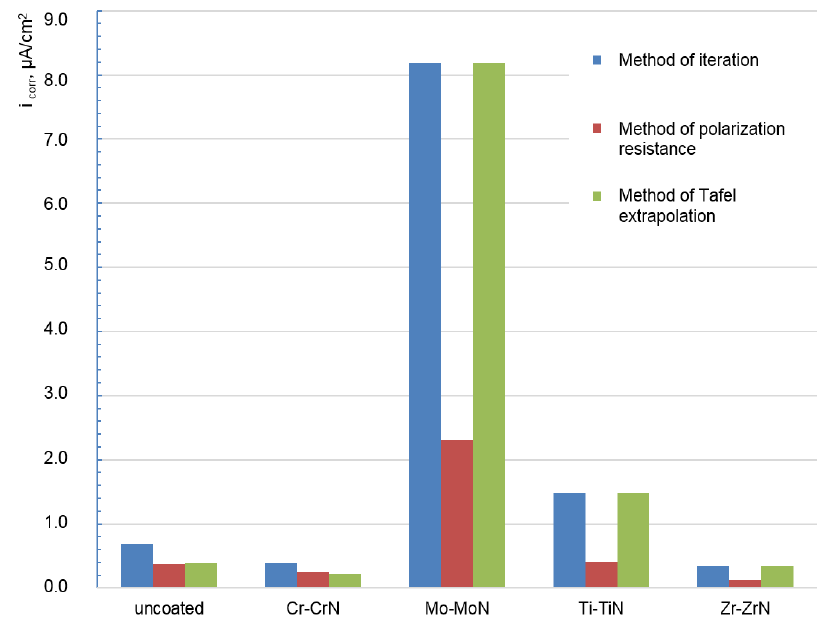
Figure 8. Comparative diagram of the corrosion current density values for the plates made of Ti-6Al-4V alloy and coated with Cr-CrN, Ti-TiN, Zr-ZrN, and Mo-MoN in the 3 wt.% solution of NaCl, calculated by mathematical modeling of the corrosion process by the methods of iteration, polarization resistance, and Tafel extrapolation.